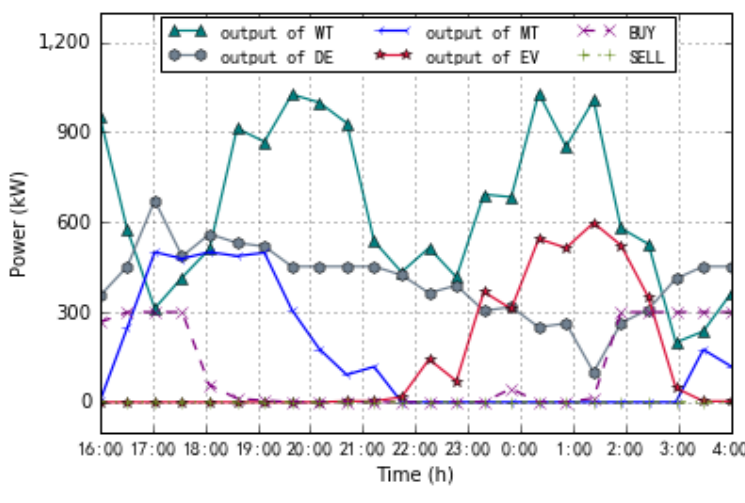
Figure 5. Stochastic optimization result.